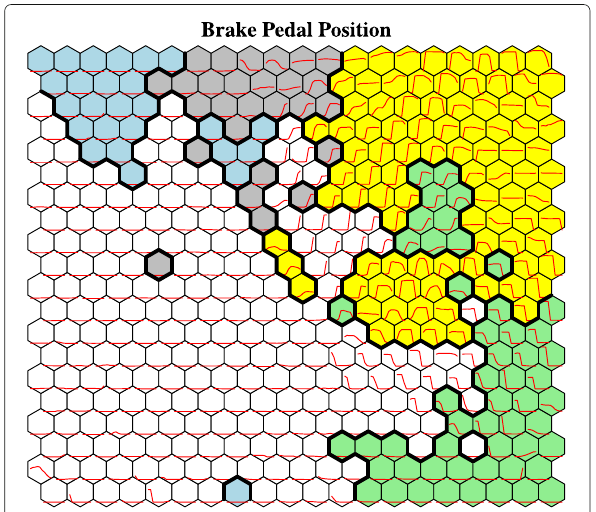
Fig. 6 Velocity map with clusters. 10-second velocity curve for each node represented as a line plot within the respective node